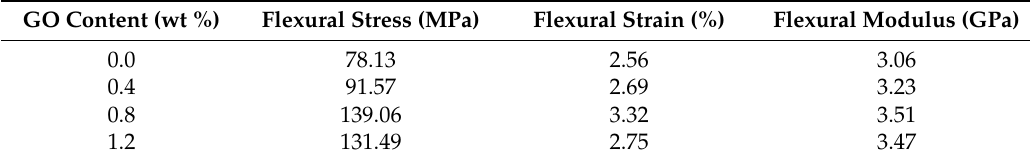
Table 2. Flexural properties of nanocomposites with different GO content at room temperature.